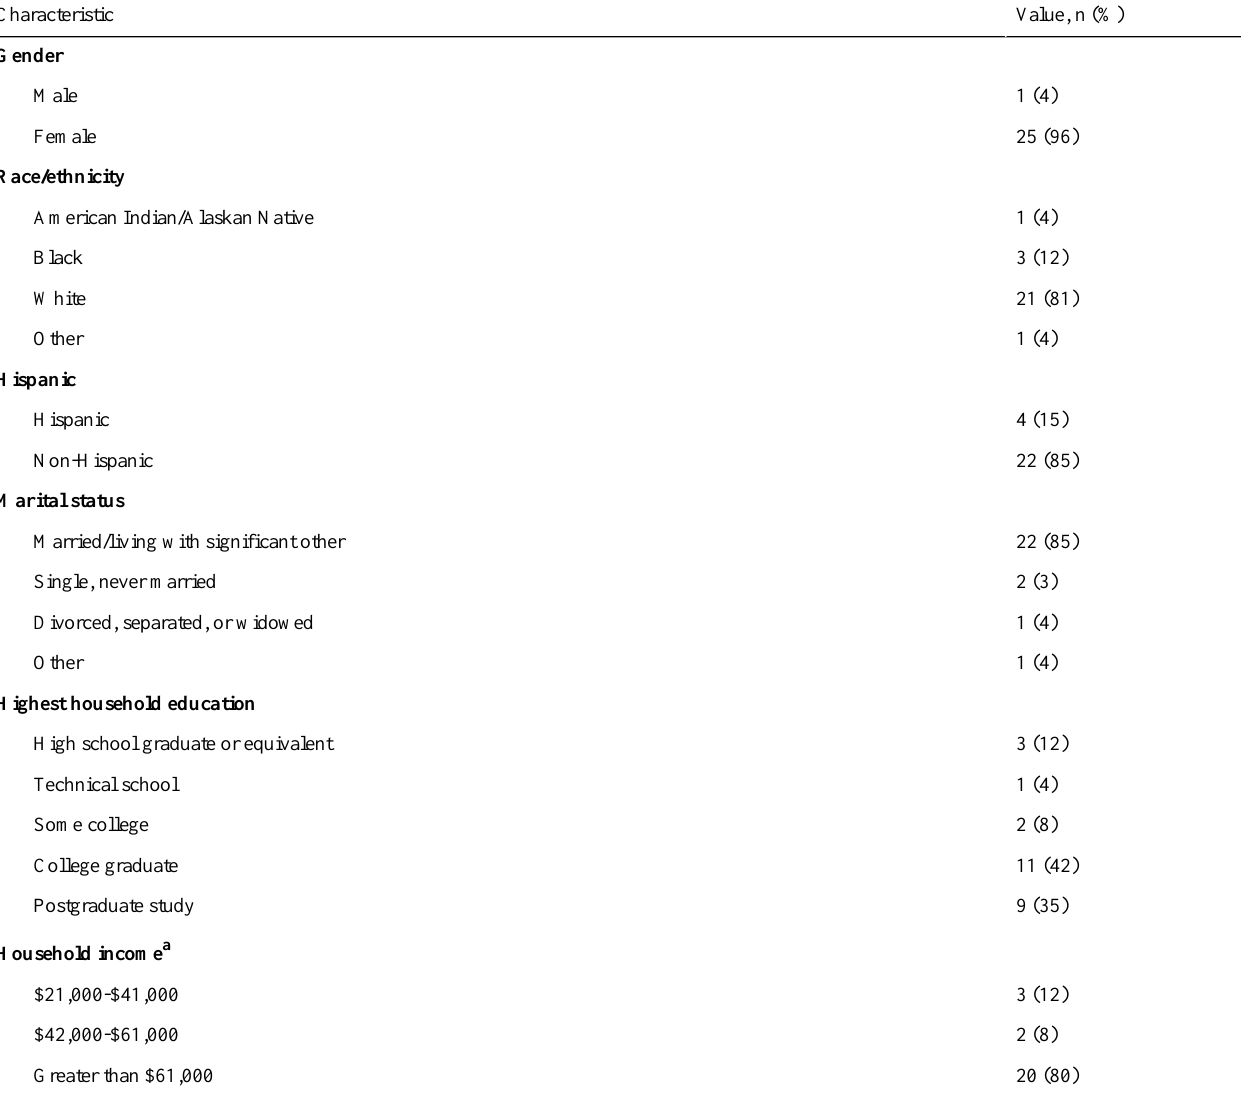
Table 4. Descriptive statistics of parents who completed the Diabetes Family Teamwork Online study